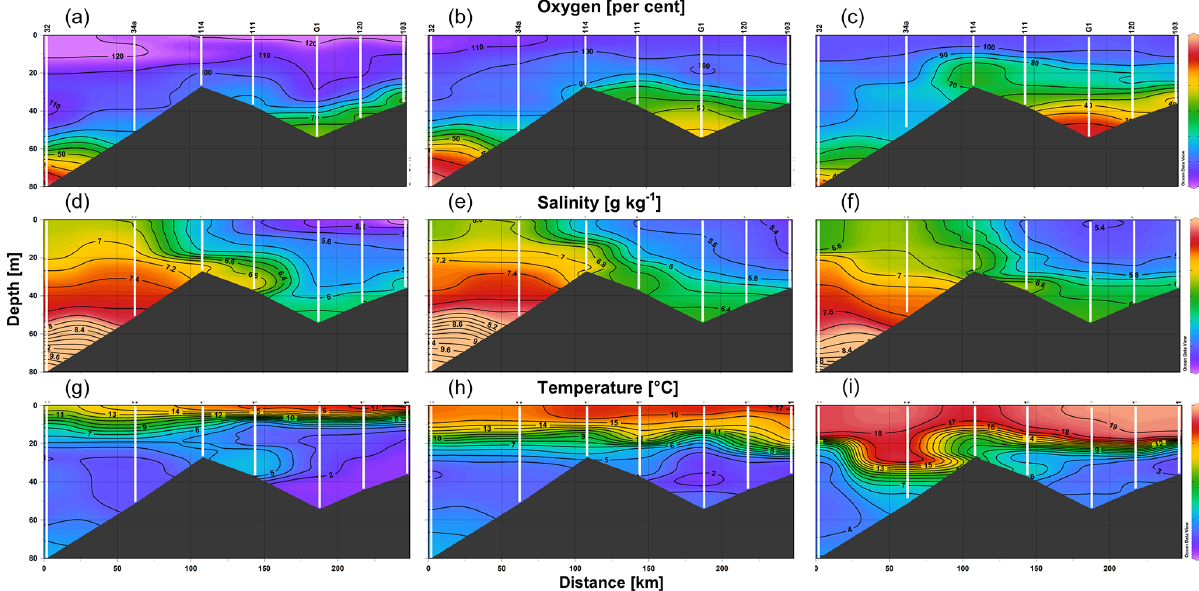
Figure 5. Vertical sections of oxygen saturation (a–c) , salinity (d–f) , and temperature (g–i) on 30 May (a,d,g) , 11 July (b,e,h) , and 25– 26 August (c,f,i) 2018 along the route from station 32 in the Baltic Proper through the Irbe Strait to station 103 near the Daugava River mouth in the Gulf of Riga (see the locations in Fig. 1). Table 2. Estimated changes in NBL salinity and oxygen concentration due to advection and diffusion (presented as the changes per month to ease the comparison between the periods) and estimated consumption rates from mid-April to late August 2018. Period start ( t 1 ) and end ( t 2